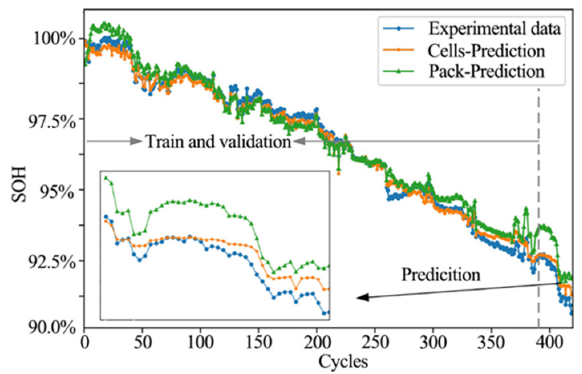
Figure 16. Comparison of the SOH prediction result for a series-parallel pack.